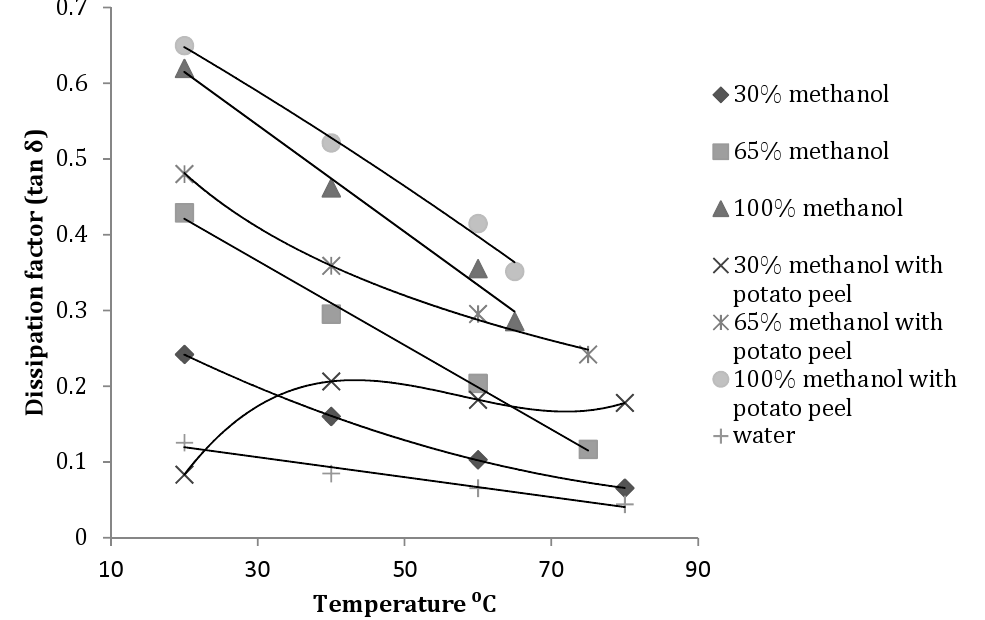
Figure 6. Dissipation factor of methanol-water mixture with and without potato peel at 2450 MHz (Source: Adapted from